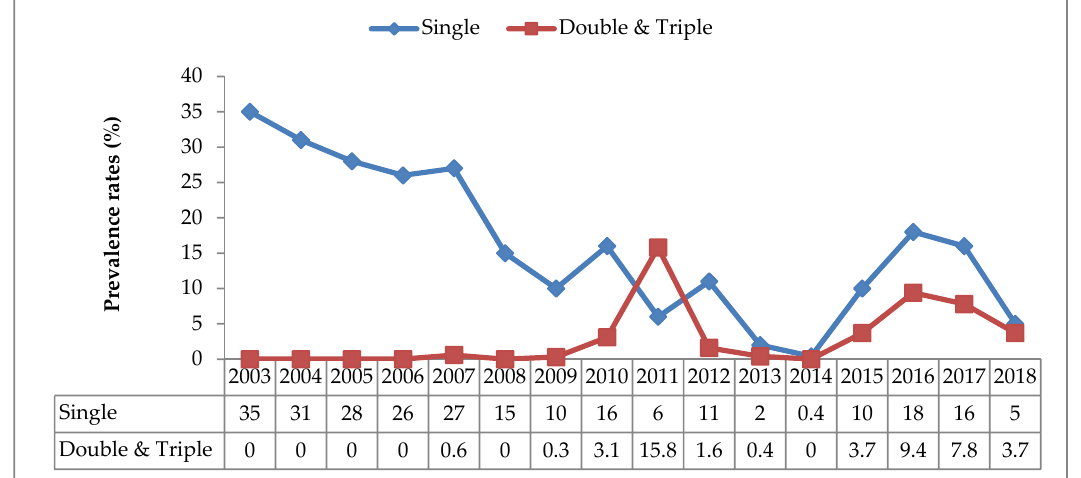
Figure 3. Comparison of trends of HBV single and co-infection prevalence rates in blood donors from 2003–2018.